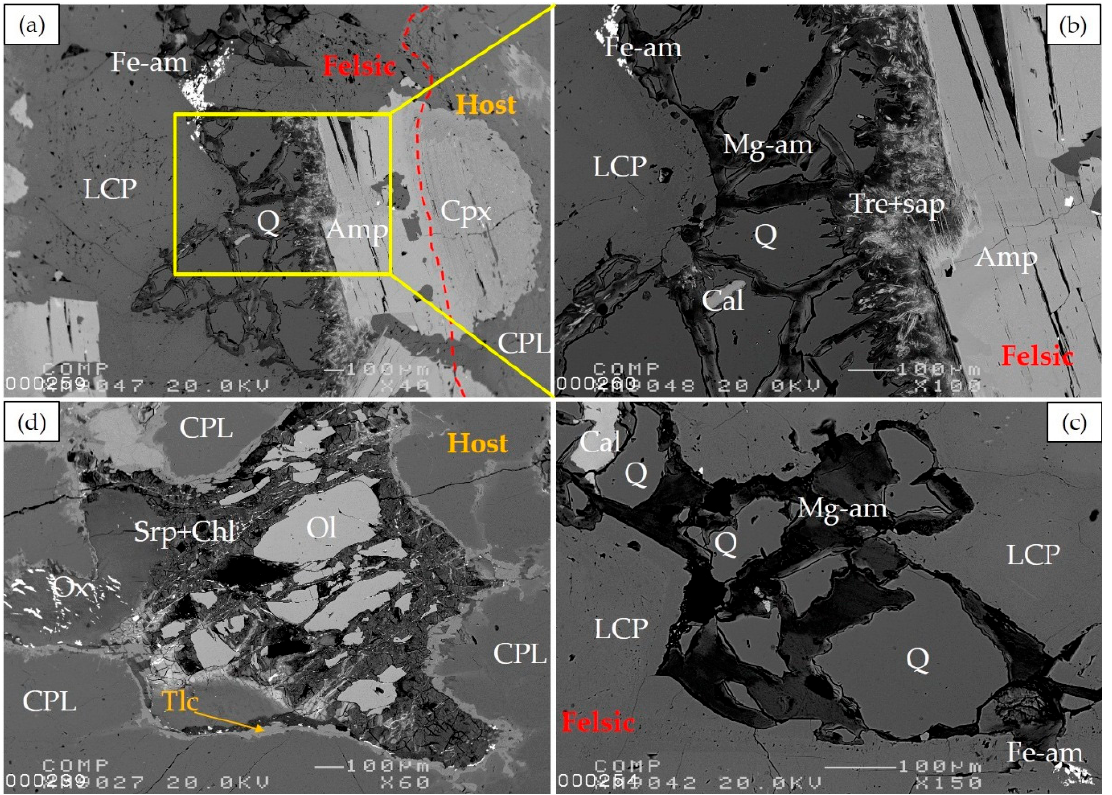
Figure 7. Occurrence of felsic-quartz and a comparison with host-olivine alteration, sample 66R5, 1–7 cm. ( a – c ) Quartz in felsic vein. ( d ) Host olivine alteration texture. CPL: Calcic plagioclase. LCP: